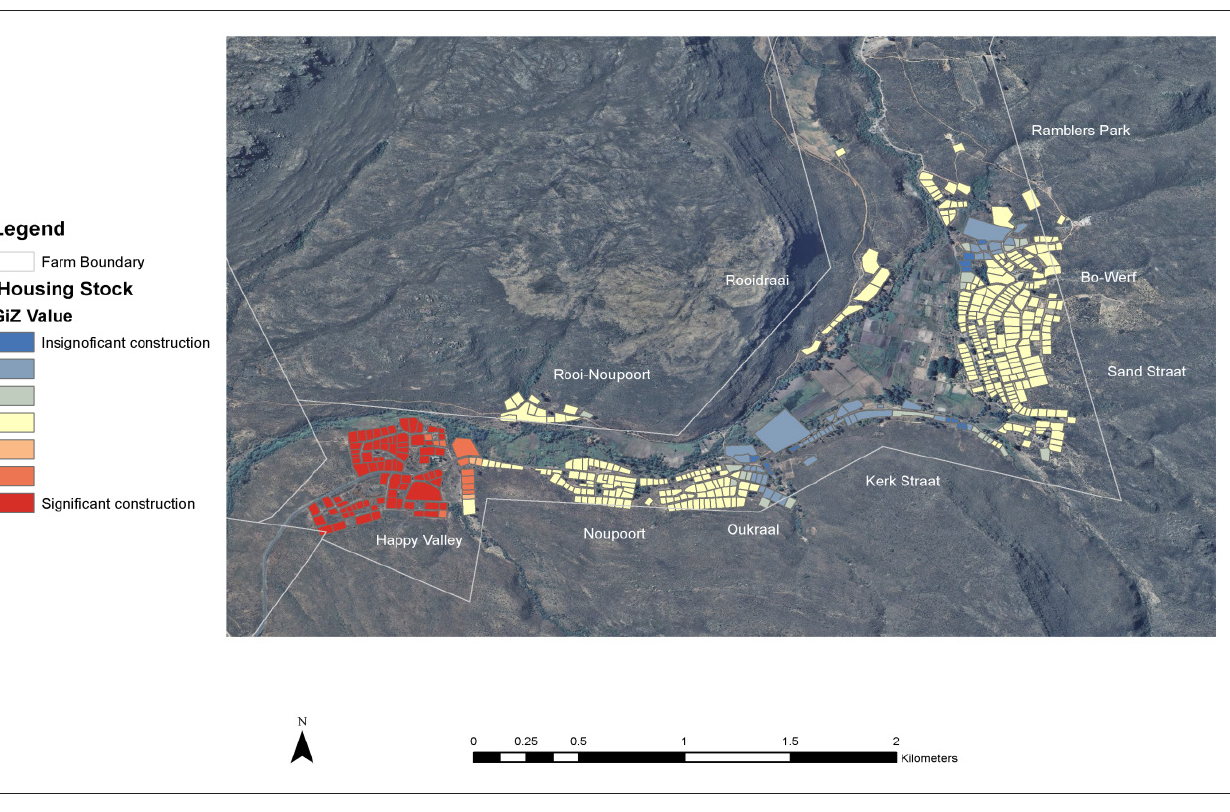
Figure 7: Building activities at Goedverwacht Source: Student Reports,